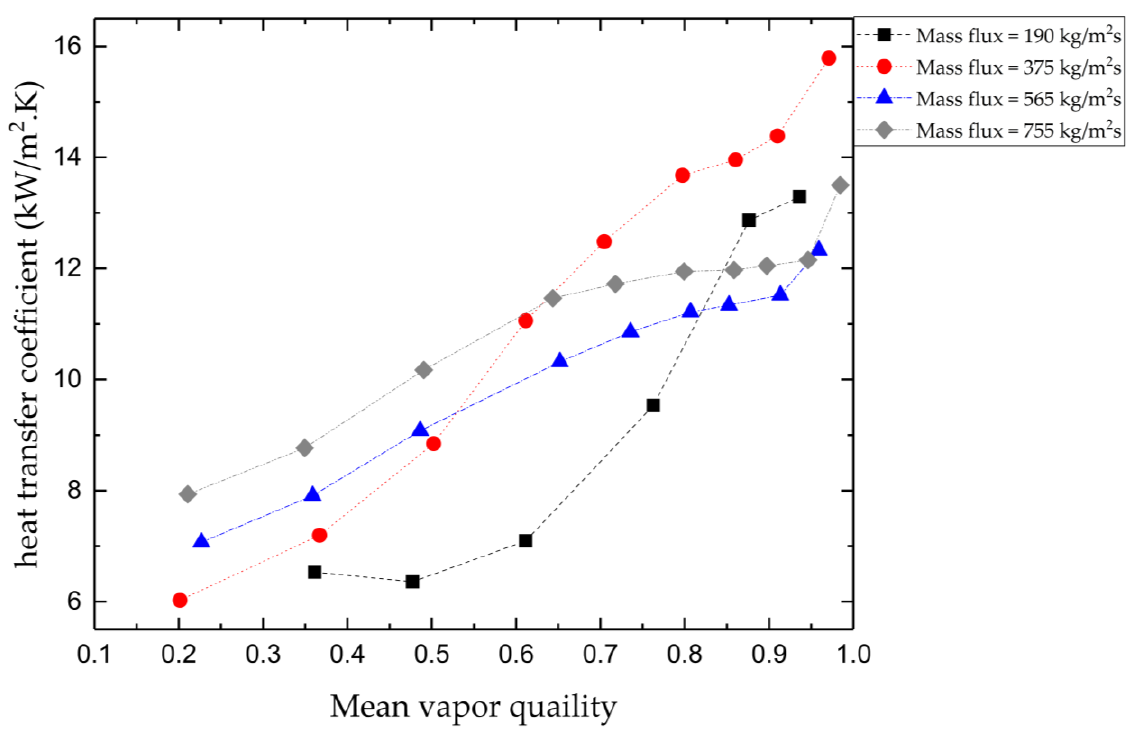
Figure 14. HTC in relation to vapor quality against mass velocities at 10 kW/m 2 [68].